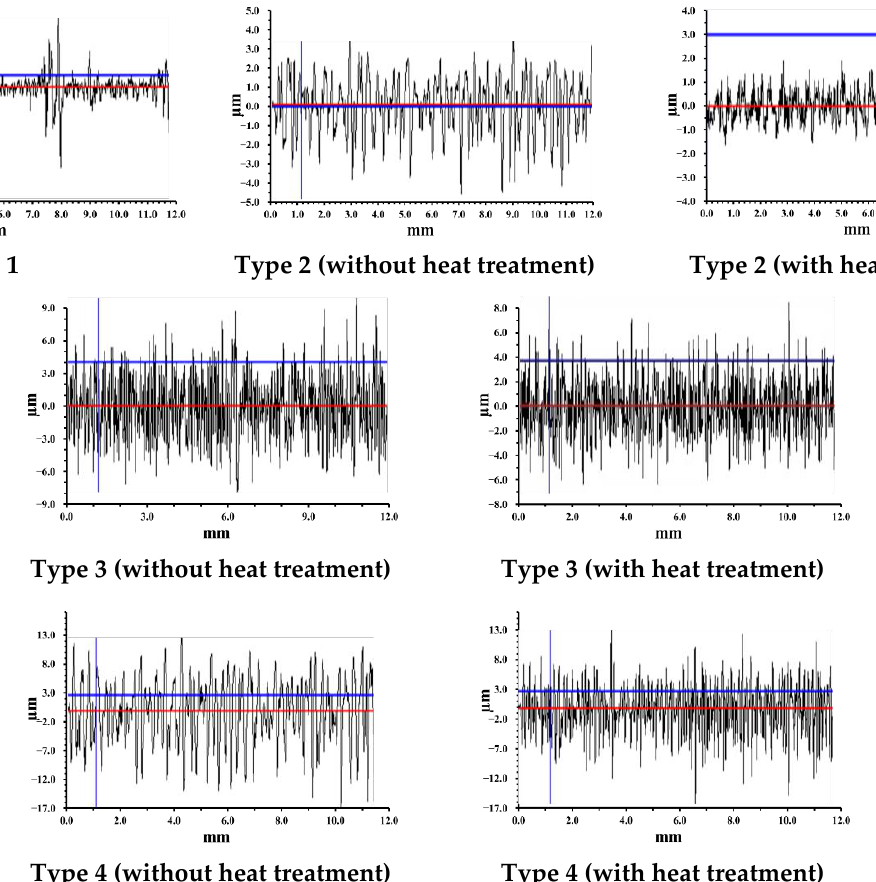
Figure 1. Profilograms of different types of zinc surface (the red line is the profile base line, blue lines are measuring lines). Table 1. Roughness parameters of zinc samples with different types of surface.